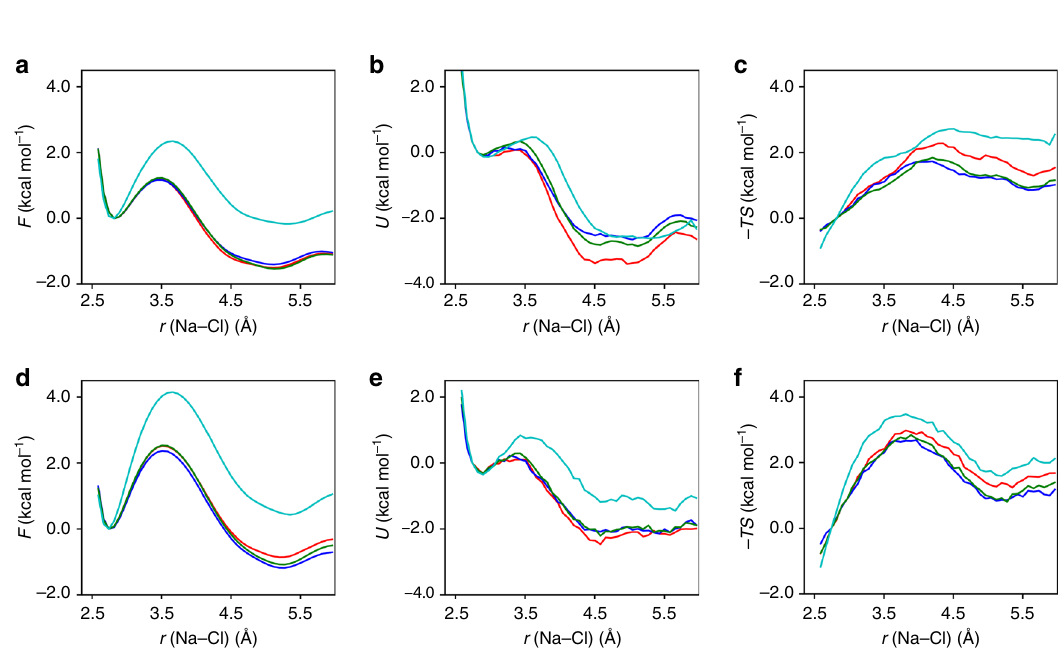
Fig. 5 Enthalpic ( U ) and entropic ( − TS ) contributions to free energy surfaces ( F ). a – c and d – f show results for NaCl solutions at concentration 0.43 M at ambient conditions and 0.68 M at 1000 K and 11 GPa, respectively. We report results obtained with four different empirical potentials : SPCE_JC (red line), SPCE_f_JC (blue line), SPCE_fa_JC (green line) and RPOL_SD (cyan